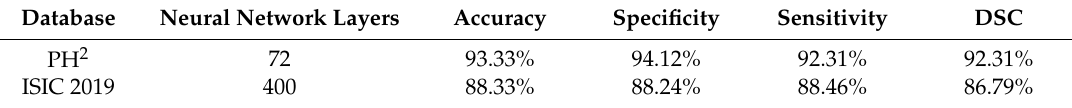
Table 3. Classification performance of the proposed neural network in the validation